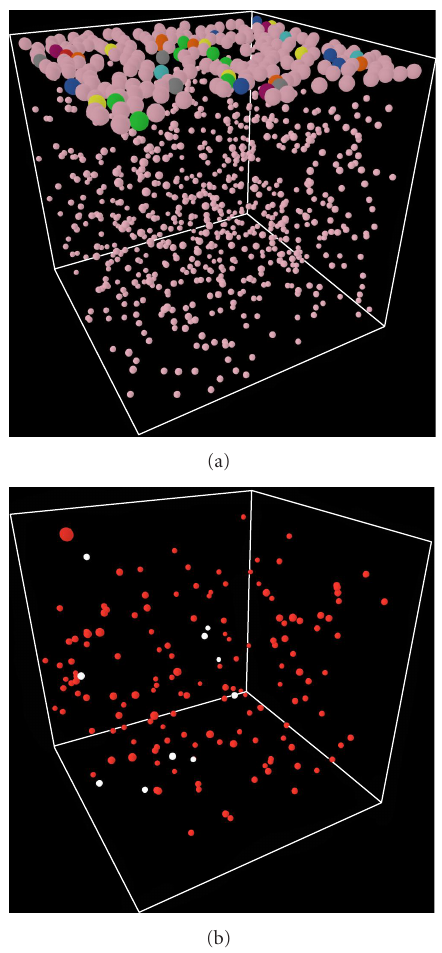
Figure 6: Acquaintance immunization of DH network. (a) Immu- nized dark-pink nodes and remaining susceptible multicolored hubs. (b) The few red and white isolated nodes after the viruses tried to